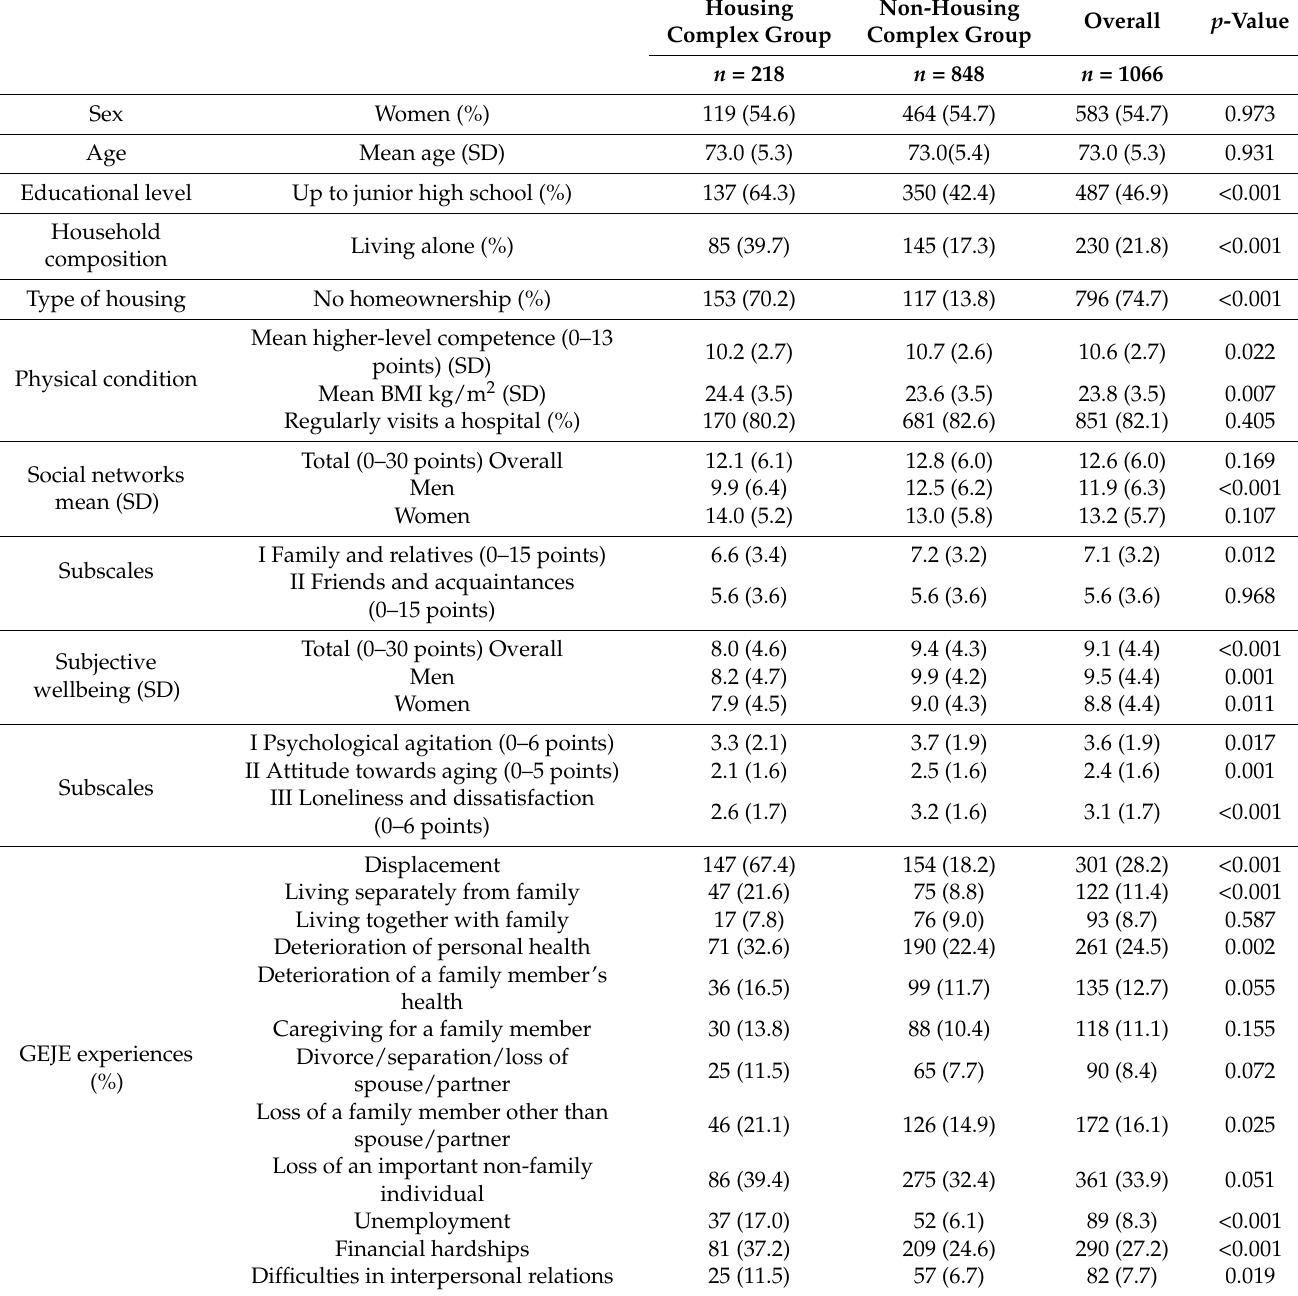
Table 1. Participant